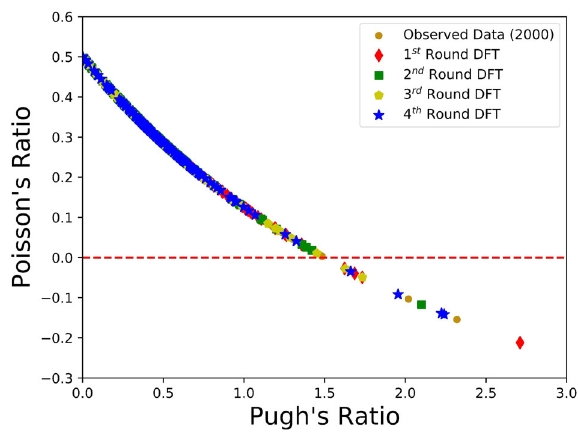
Fig. 7 Performance of BLOX algorithm in searching negative Poisson ’ s ratio materials. Observed data and all rounds of DFT calculations recommended by BLOX for Poisson ’ s ratio vs. Pugh ’ s ratio. After a few loops, we were able to fi nd 11 structures with negative Poisson ’ s ratio. The dashed line represents zero Poisson ’ s ratio and is the guide for eyes.